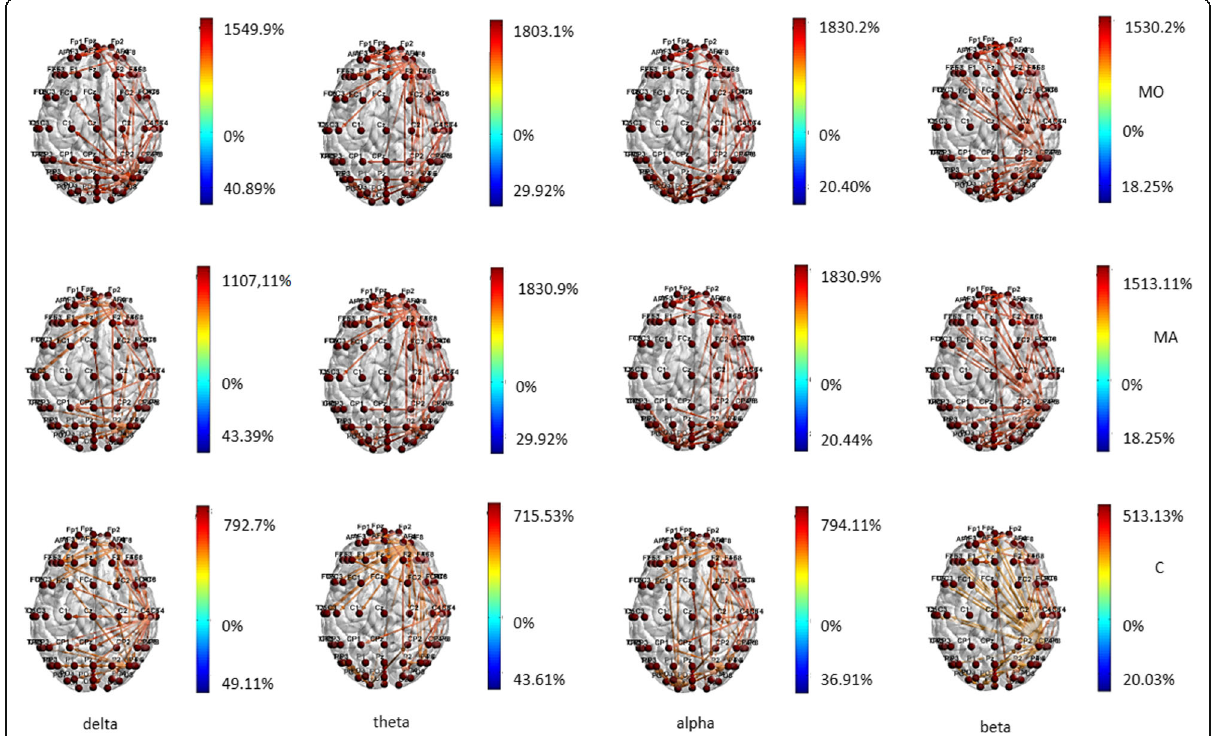
Fig. 2 Statistical differences in information transfer and their relative directions among nodes are depicted for the comparison of EEG bands under 0.5 cpd spatial frequency visual stimulation vs resting state condition in the Migraine with aura (MA), Migraine without aura (MO) and Controls (C) groups . Hot colors refer to a statistical prevalence of information transfer in the 0.5 cpd spatial frequency visual stimulation condition, cold colors for a prevalence in resting state. The color intensity is graduated on the relative percent difference. (further data on statistical analysis are available in the Additional file 1: section, chapter